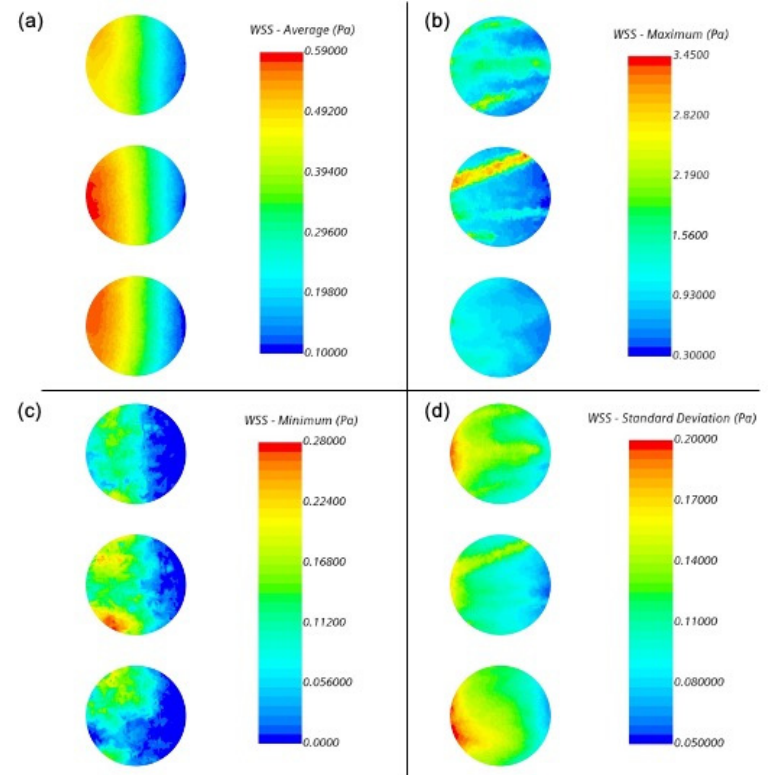
Figure 8. The wall shear stress on one vertical rod of coupons between revolutions 20 and 70, with the baffle moving across the surfaces from left to right. ( a ) is the average wall shear stress magnitude over all revolutions, while ( b ) is the absolute maximum observed during the 50 revolutions, ( c ) is the absolute minimum, and ( d ) is the standard deviation.